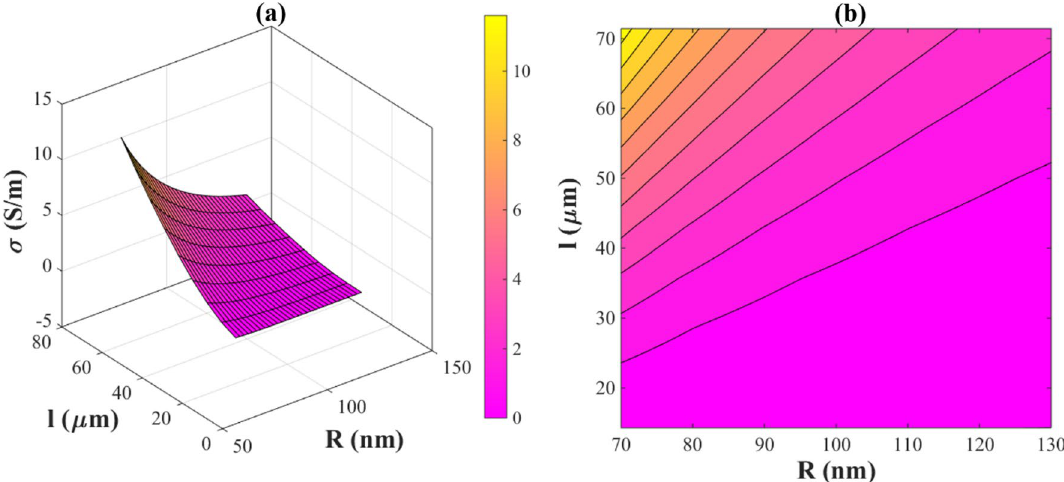
Figure 5. The influences of “R” and “l” on the electrical conductivity of PNCs by ( a ) 3D and ( b ) contour plots.